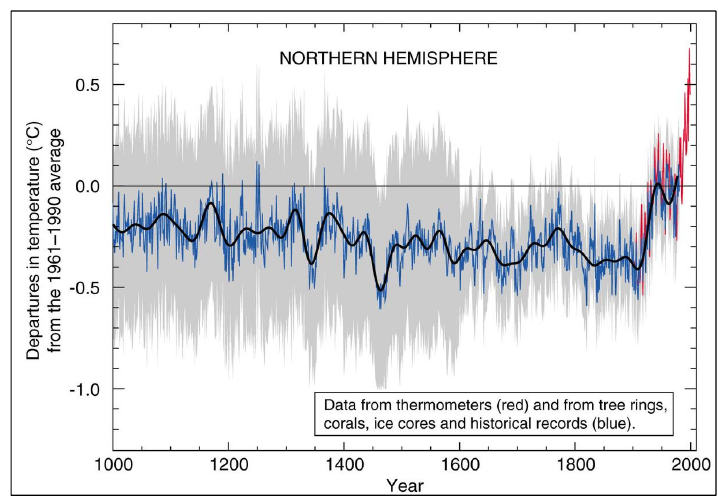
Figure 9. Michael Mann’s “hockey stick graph.” Photograph: IPCC report, 1990.